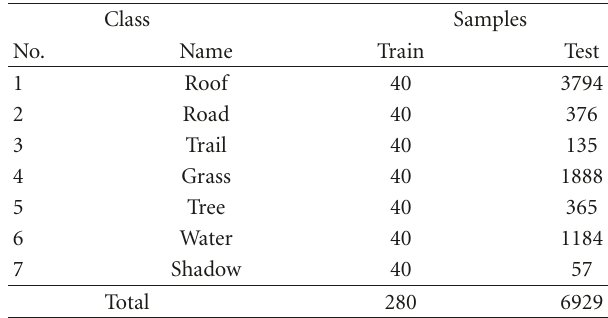
Table 3: Information classes and training/test samples for the Washington DC Mall data